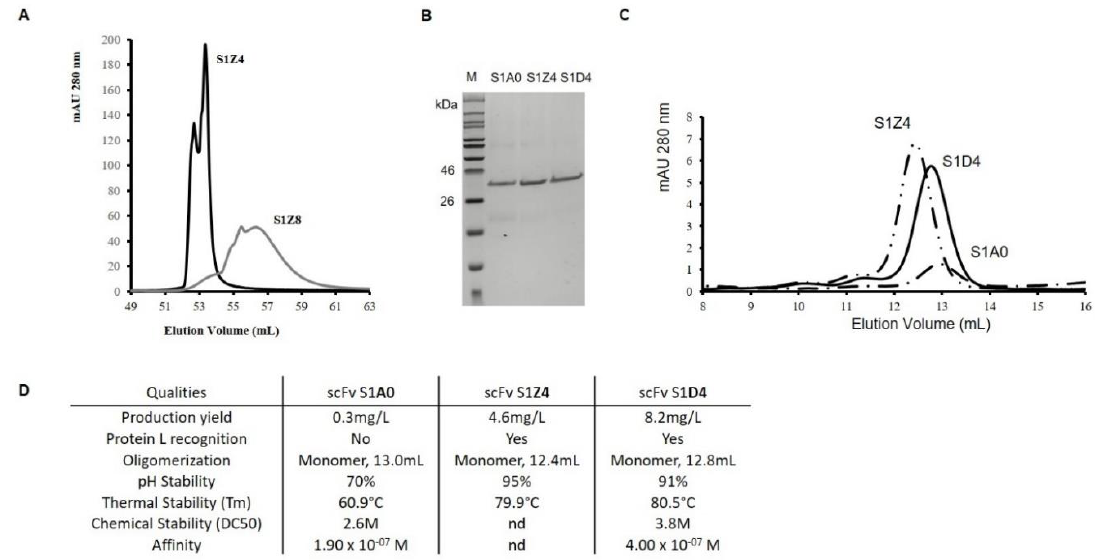
Figure 4. Structural and functional characterization of the scFvs S1Z8, S1Z4, and S1D4. ( A ) Affinity chromatography in a HiScreen ™ Capto ™ L column. The chromatogram shows the elution profiles of S1Z4 (black line) and S1Z8 (grey line), demonstrating a faster and more concentrated elution for S1Z4. ( B ) SDS-PAGE analysis on purified scFv variants under reducing conditions. M: Molecular marker. ( C ) Analytical Size-exclusion chromatography (SEC) chromatogram on a calibrated Superdex 75 10 / 300 GL column of the following purified scFv variants: wild-type S1A0 (one dot-dashed line), S1Z4 (two dot-dashed line) and S1D4 (solid line). ( D ) Production yield and biophysical properties of the three analyzed scFvs.